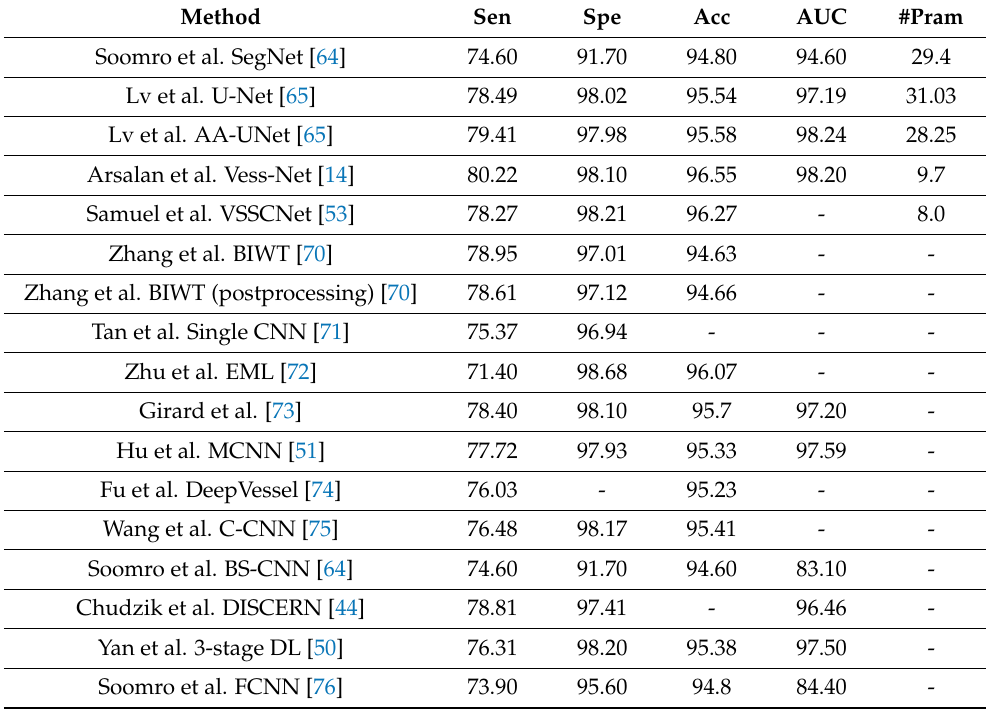
Numerical comparison of the proposed VSUL-Net with existing methods for the DRIVE